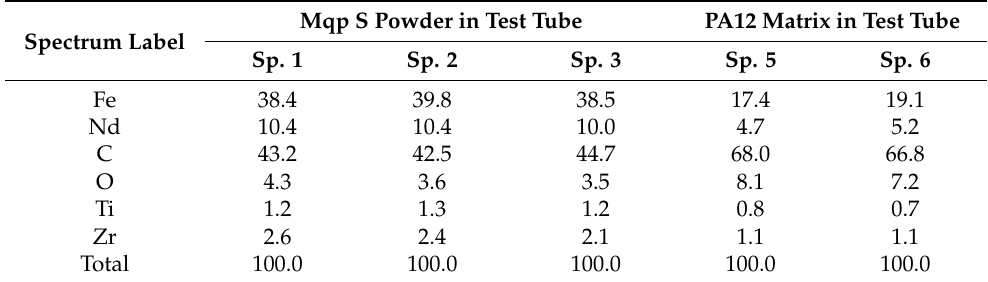
Figure 9. SEM image of surface fracture of dog-bone-shaped specimen, FDM-printed from filament S90/10. Nd–Fe–B were pulled out of the polymer matrix. Table 8. Elemental composition (wt.%) of the surface fracture of dog bone specimen made from filament